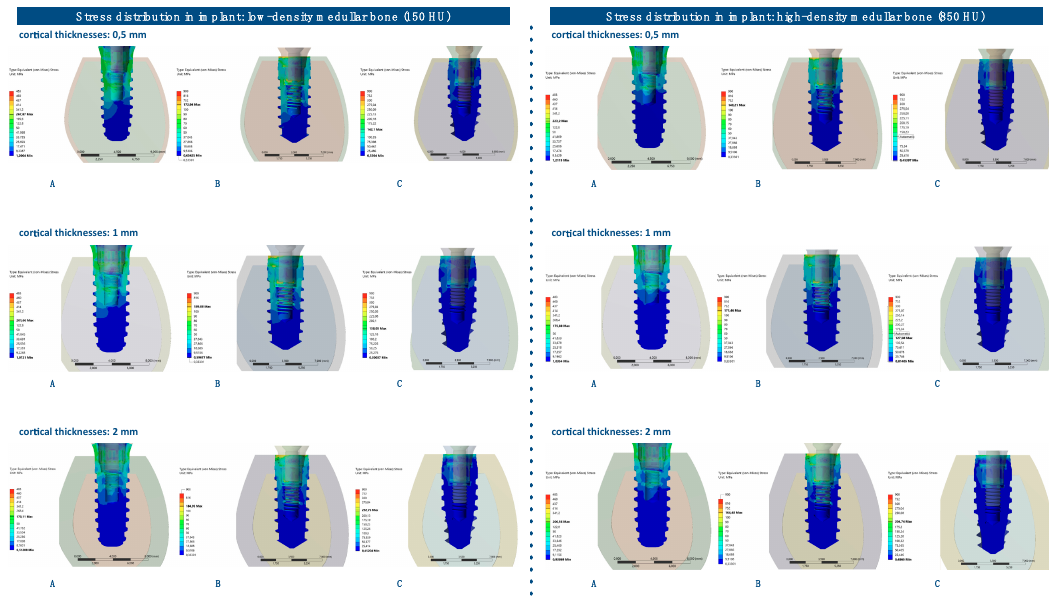
Figure 14. von Mises stress distributions in implants for all implant designs: A, B, and C. Note: the figure is in very high resolution to be able to be enlarged: enlarge it in your word processor or view it in HTML